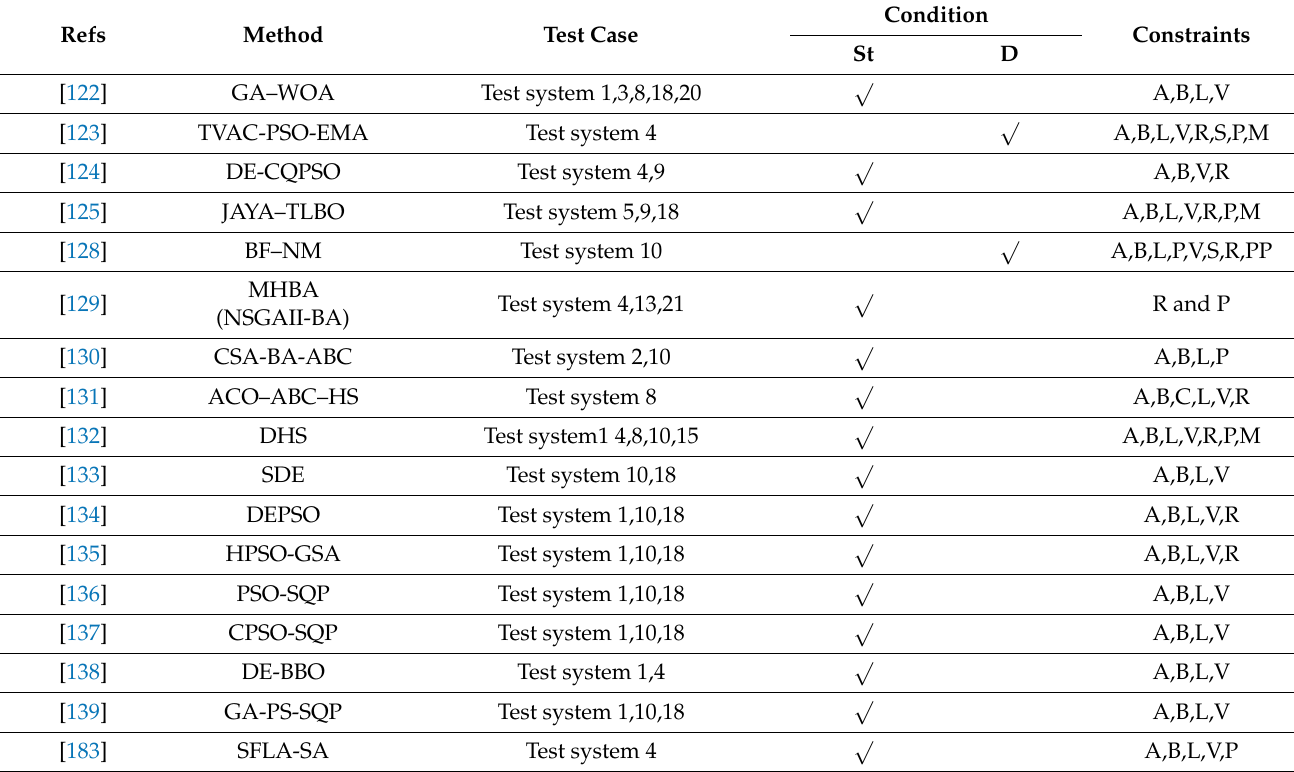
Table 4. Summary of the hybrid techniques related to the CEED